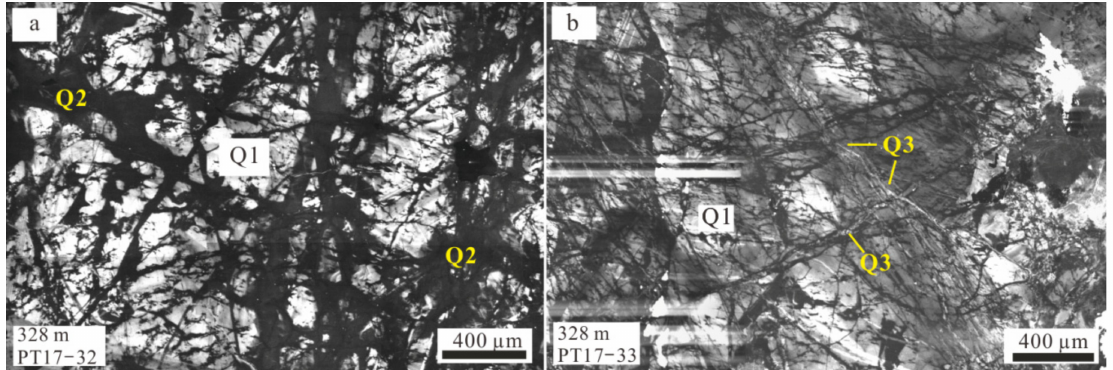
Figure 11. Composite SEM–CL panchromatic images of the samples PT17-32 ( a ) and PT17-33 ( b ) at the 328 m level. ( a ) The CL–bright generation of quartz (Q1) is crosscut by a late CL–dark generation of quartz; ( b ) The first generation of quartz (Q1) is crosscut by another late CL–bright generation of quartz (Q3), part of which was crystallized along micro